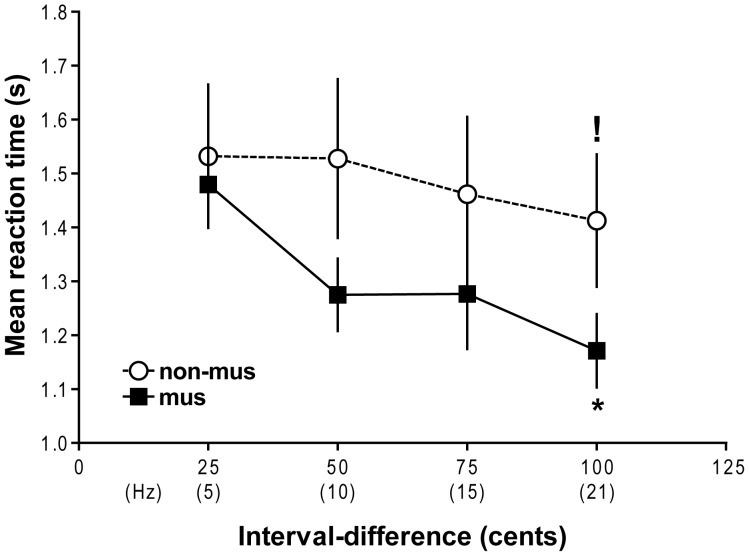
Mean ± SEM reaction times (in seconds) for musicians and non-musicians, averaged across all timbres.Musicians answered marginally faster than non-musicians at a 100-cent interval-difference (marked by *, p<0.09). Within the non-musician group, reaction times were faster at an interval-difference of 100 cents, compared to 25 and 50 cents (indicated by!, p<0.01).